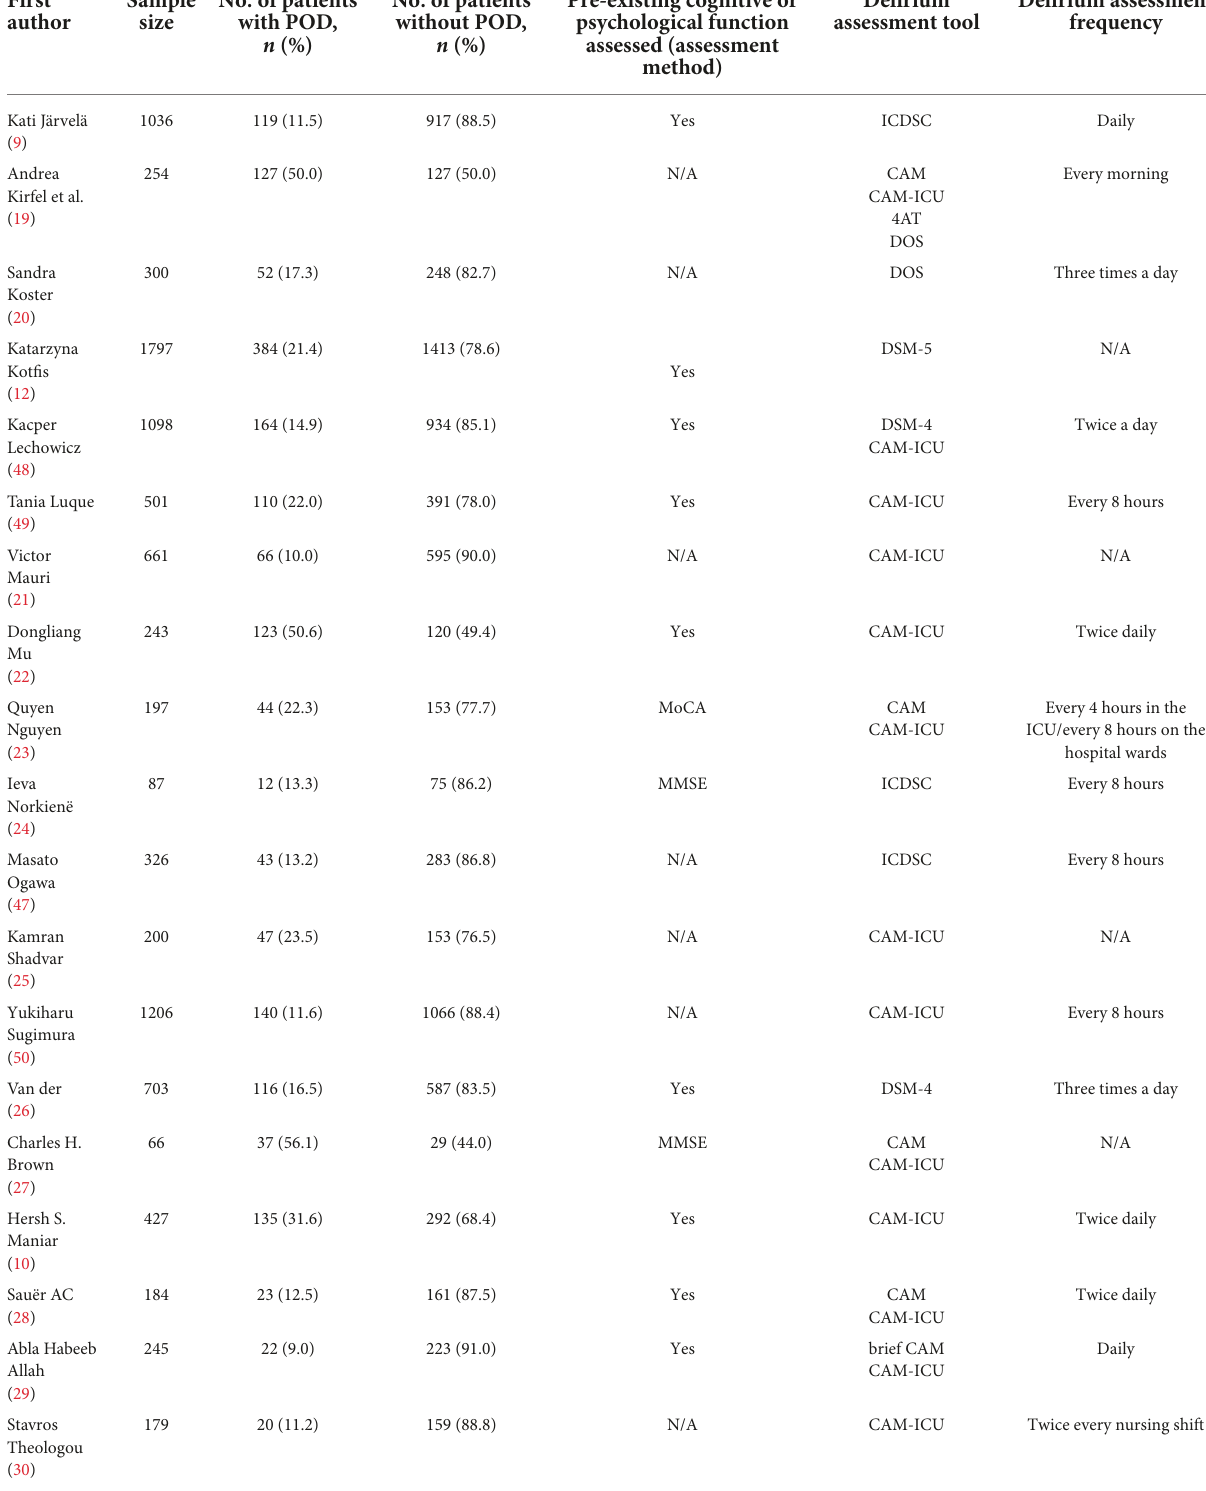
TABLE 2 Postoperative delirium screening and prevalence data from the included